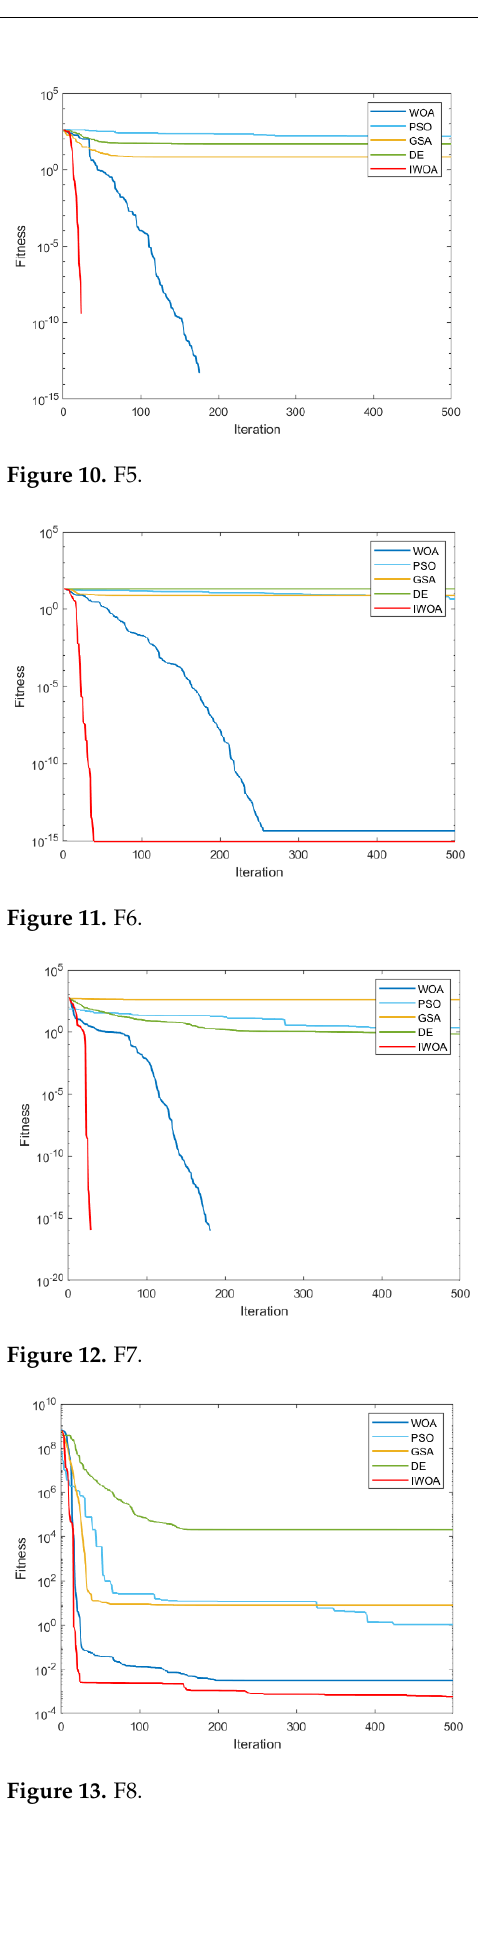
Figure 14. F9. Figure 14. F9.